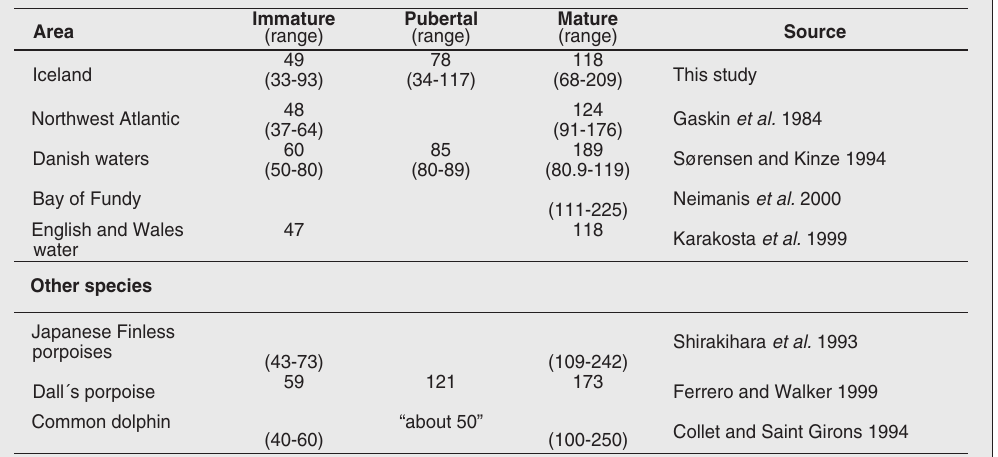
Table 4. Comparisons of seminiferous tubule size (µm) by maturity stage in harbour por- poises and some other species of similar